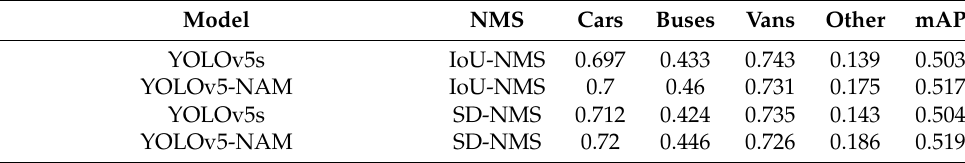
Table 4. The detection results on UA-DETRAC